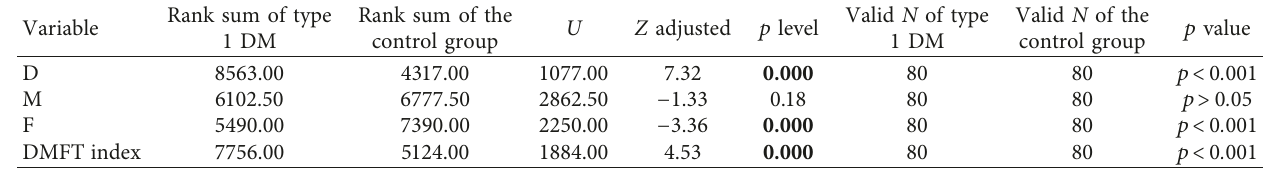
Table 2: Difference in D, M, F, and DMFT index between groups.